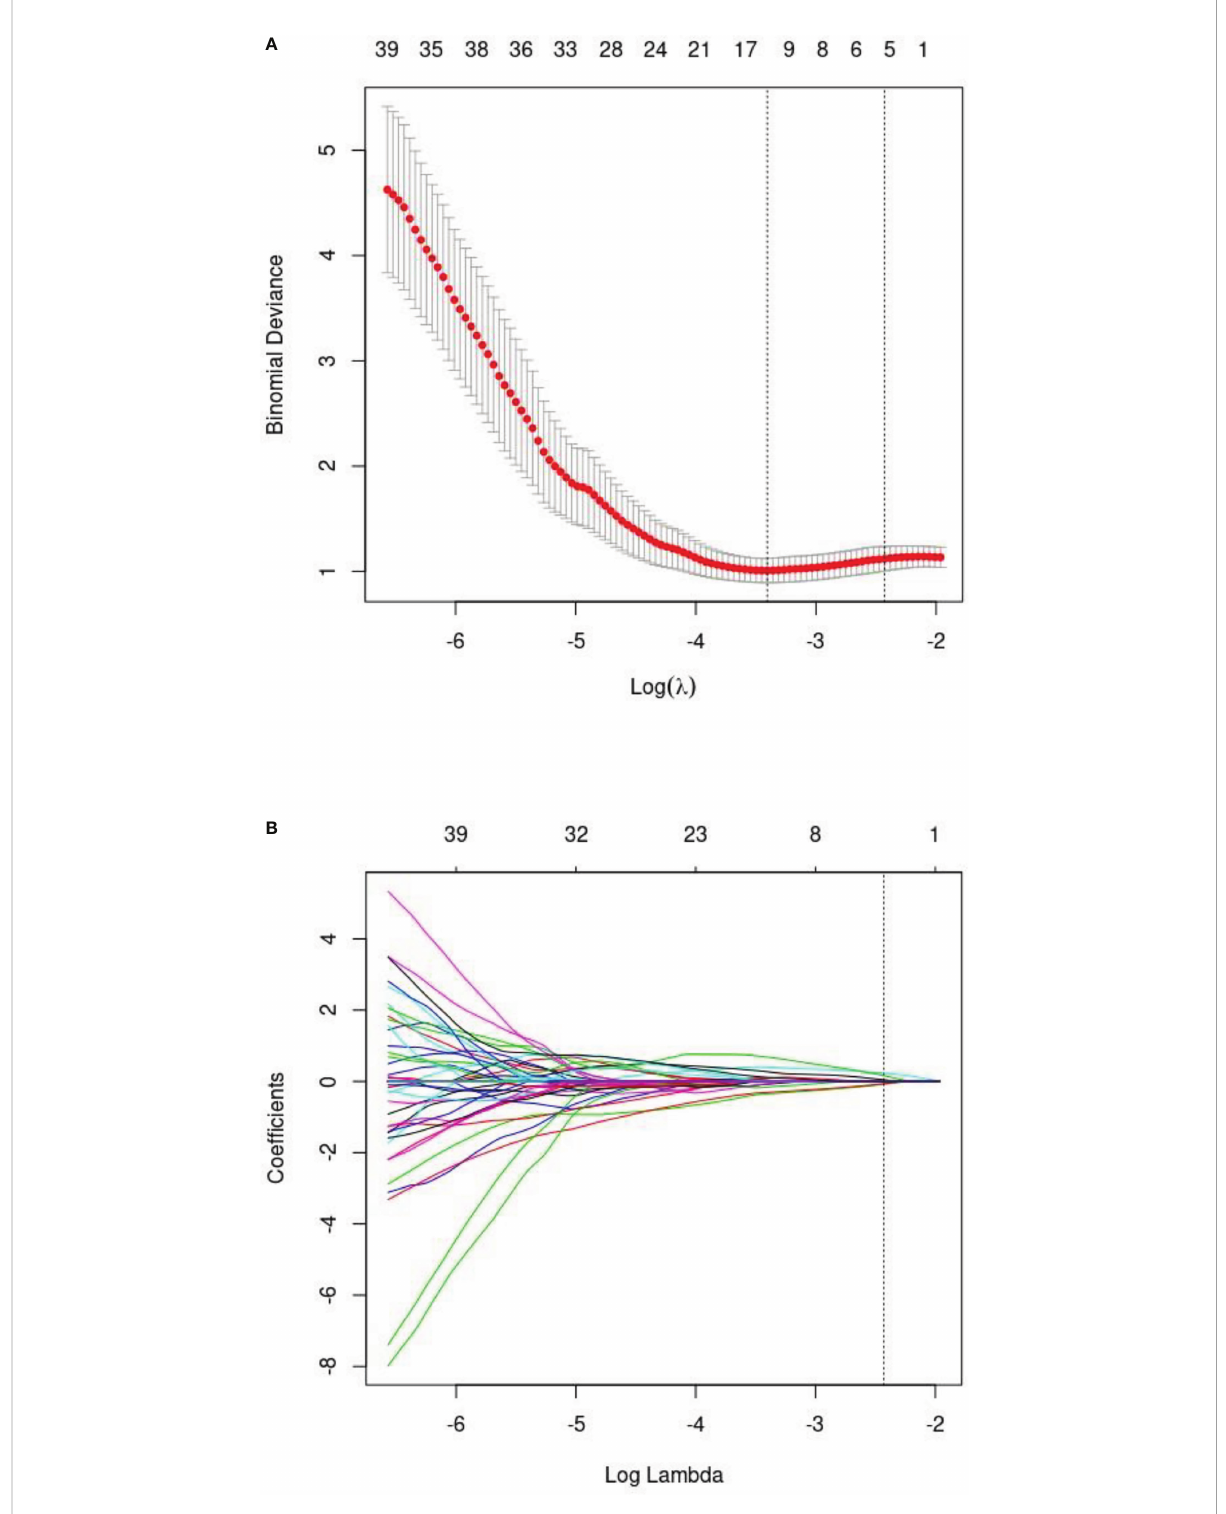
FIGURE 3 (A) The least absolute shrinkage andselection operator (LASSO) logistic regression for radiomics features selection and signature construction. (B) On the basis of minimum criteria for the least cross-validation binominal deviance, a tuning parameter (l) was selected via 10-fold cross validation.according to 10-fold cross-validation, 10 radiomic features were